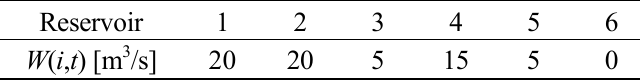
Table 3. Natural water inflow of the reservoir